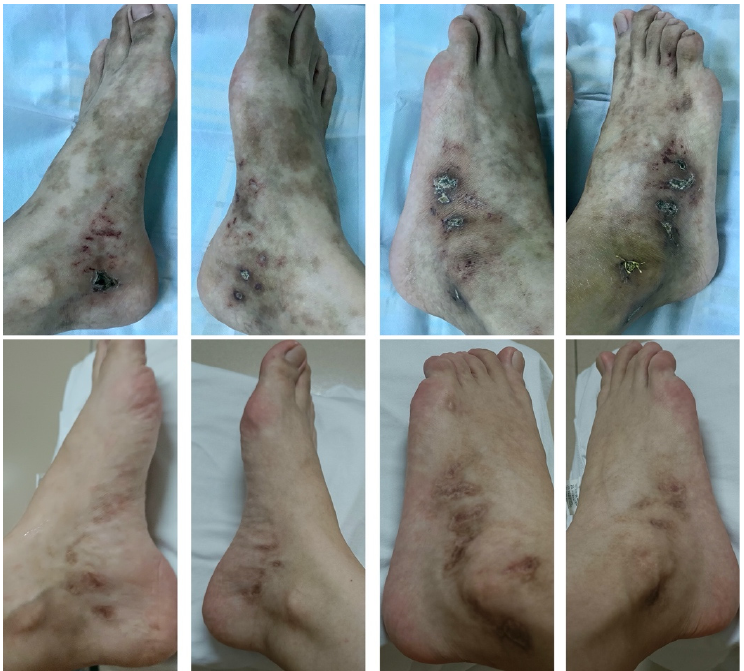
Figure 2. Clinical images of patient 2 before and 4 months after adalimumab treatment.